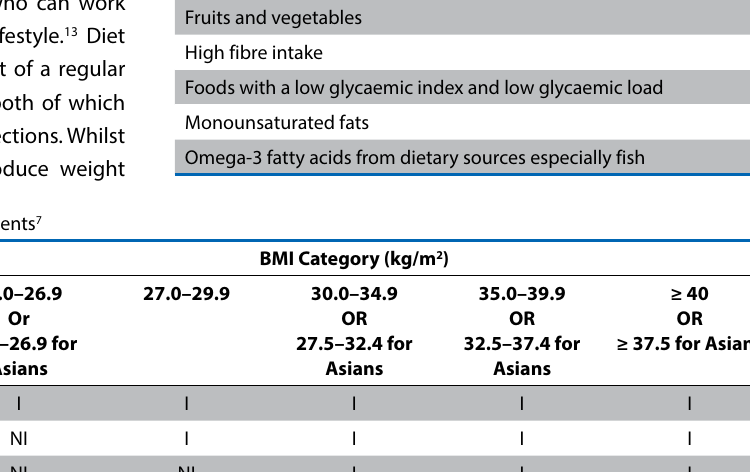
Table 5: Components of a healthy diet 13,21 The components of a healthy diet include intakes of: